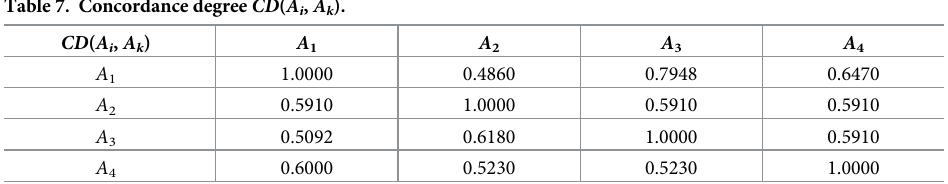
Table 7. Concordance degree CD ( A i , A k